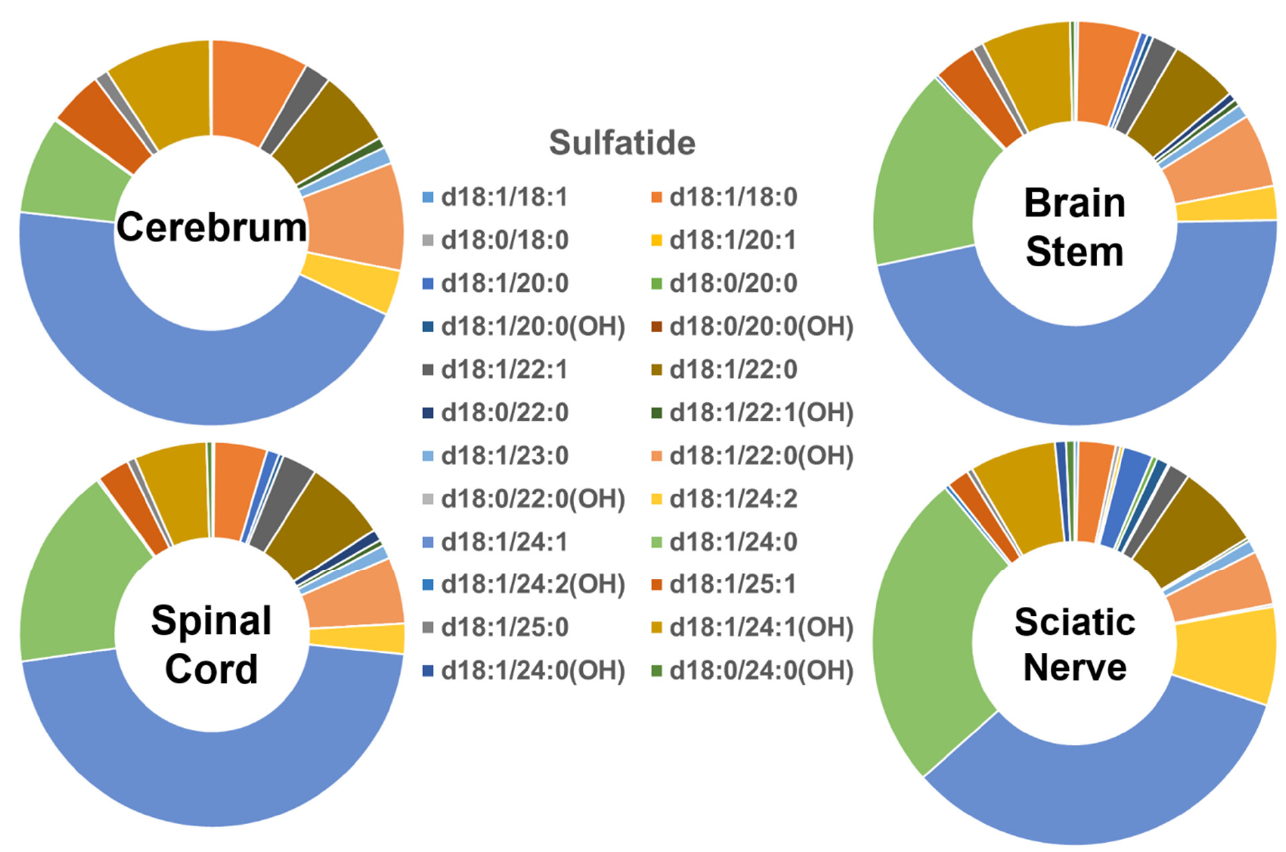
Figure 4. Comparison of sulfatide molecular species profiles in cerebrum, brain stem, spinal cord, and sciatic nerve tissues from 2 mo-old mice. Levels of individual sulfatide molecular species were assessed via shotgun lipidomics; the relative abundance of each species compared to the total class content is displayed in the form of pie graphs (Excel).